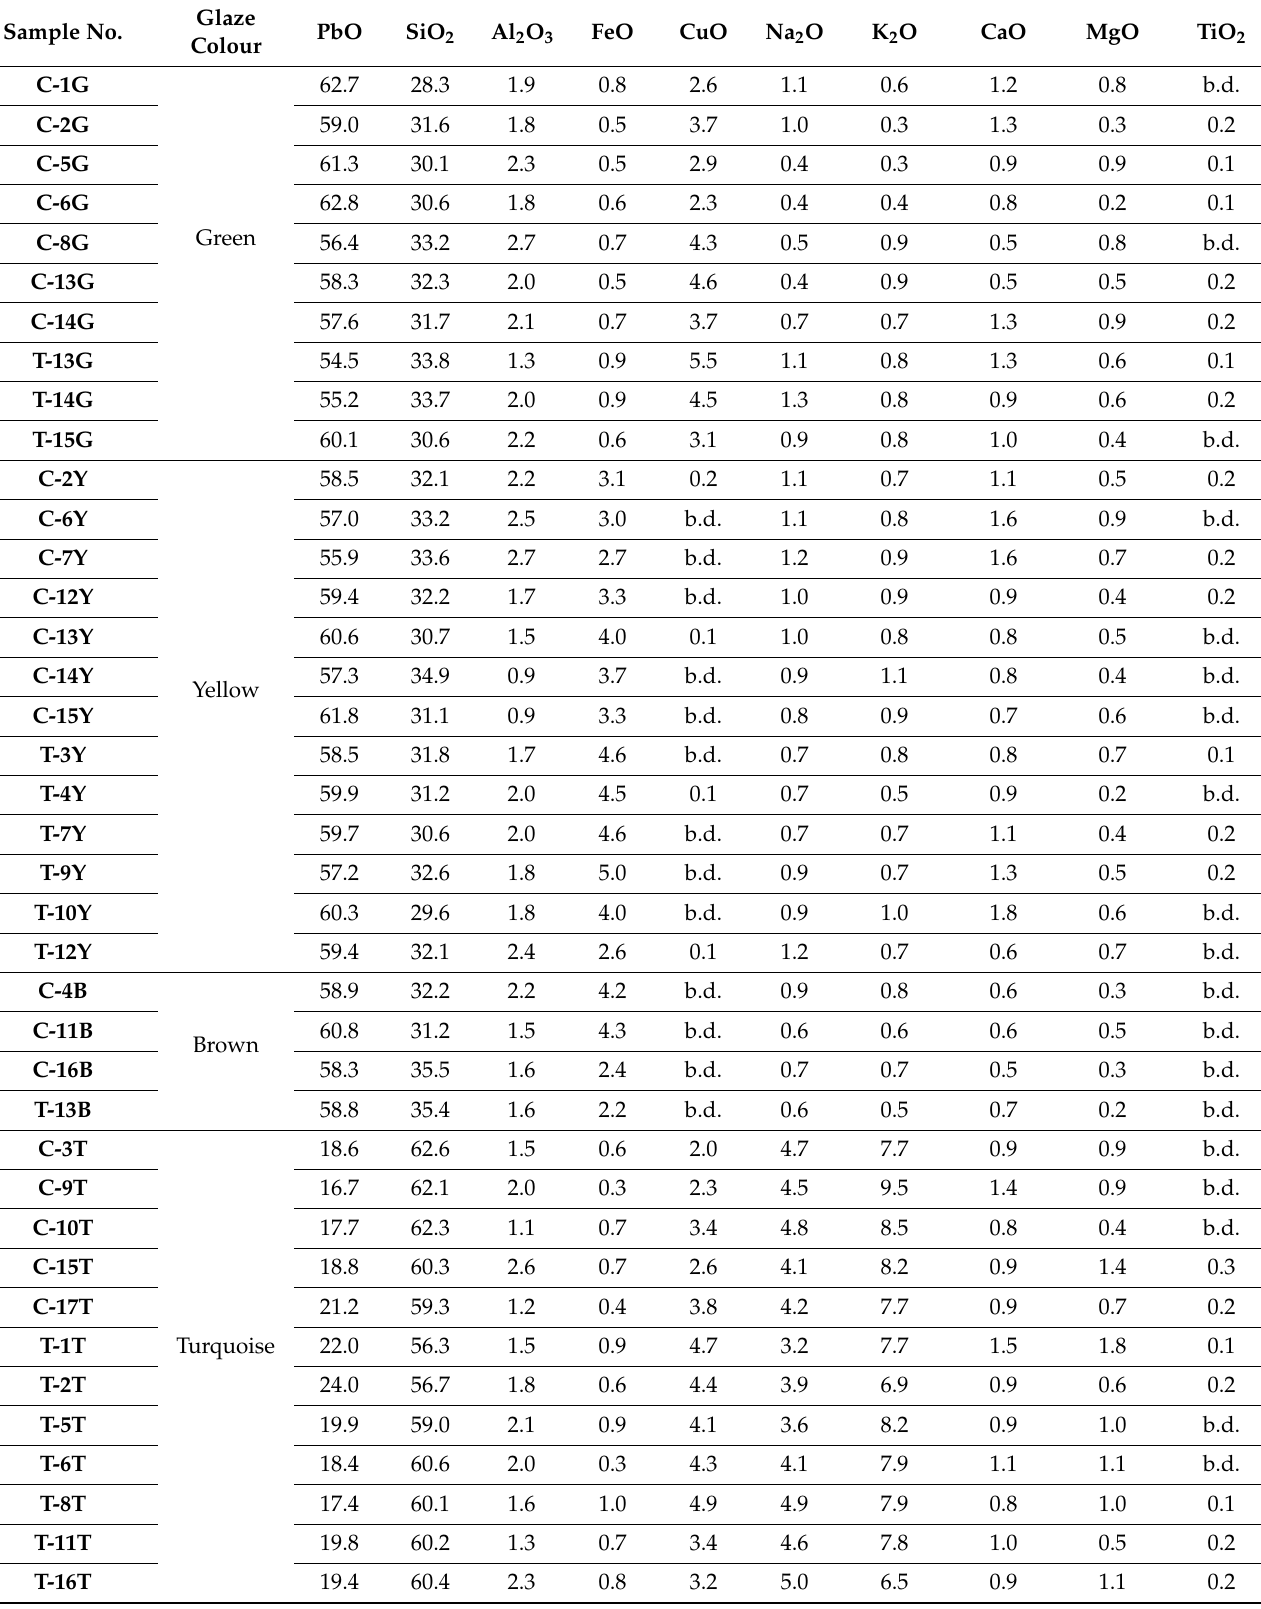
Table 4. Major chemical compositions of the glaze of Hancheng glazed tile samples (wt.%, b.d. means below the detec- tion